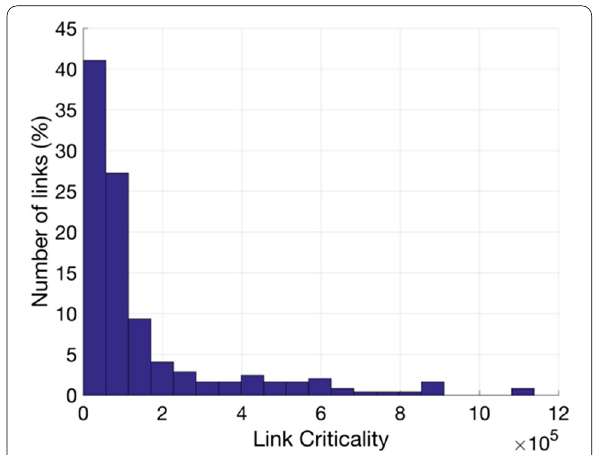
Fig. 3 [12] link criticality study